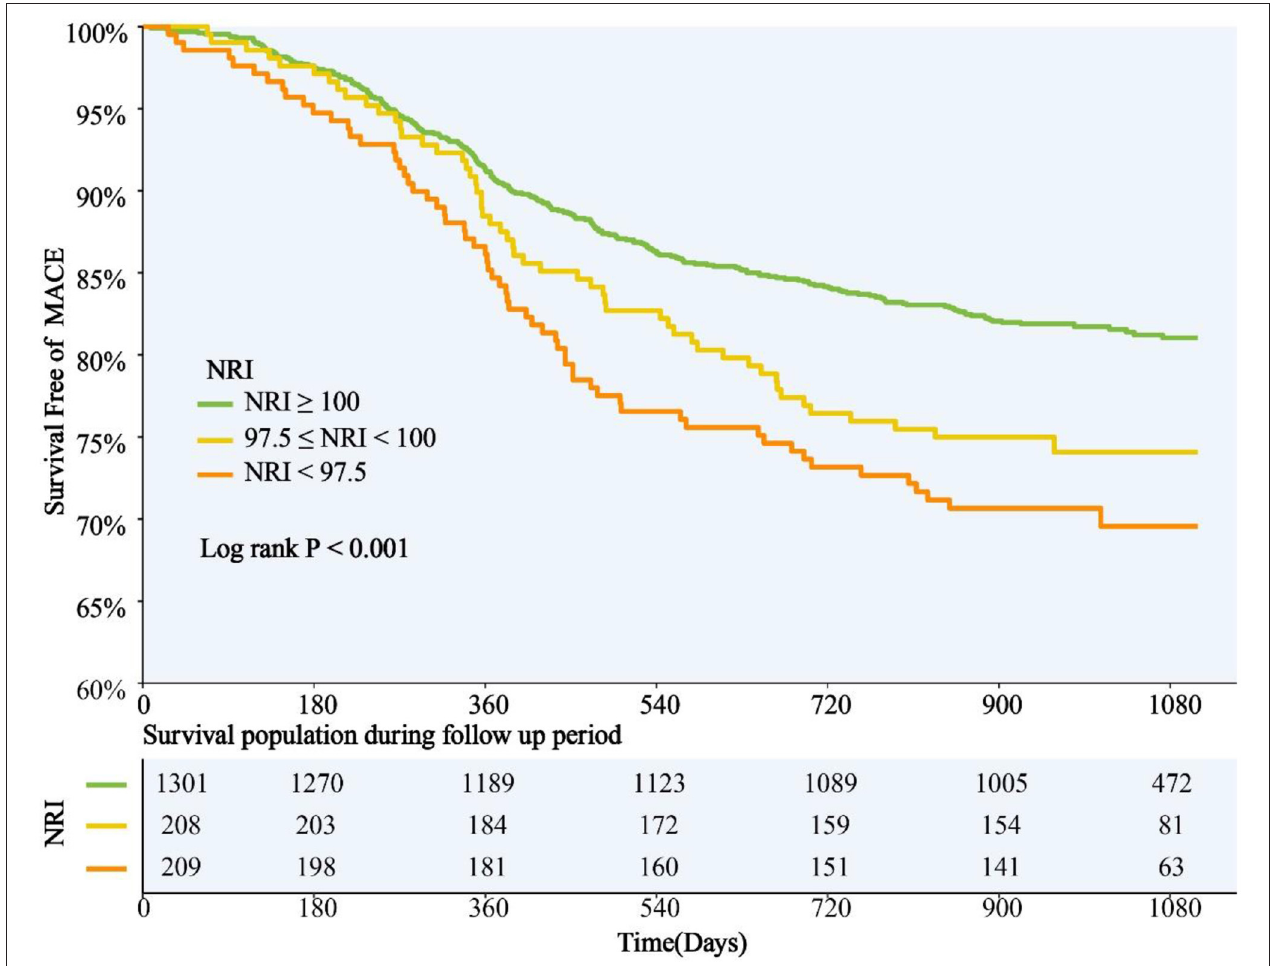
FIGURE 3 | NRI Degree and Risk of MACE. Kaplan-Meier curves for MACE by the NRI degree. NRI, nutritional risk index; MACE, major adverse cardiovascular